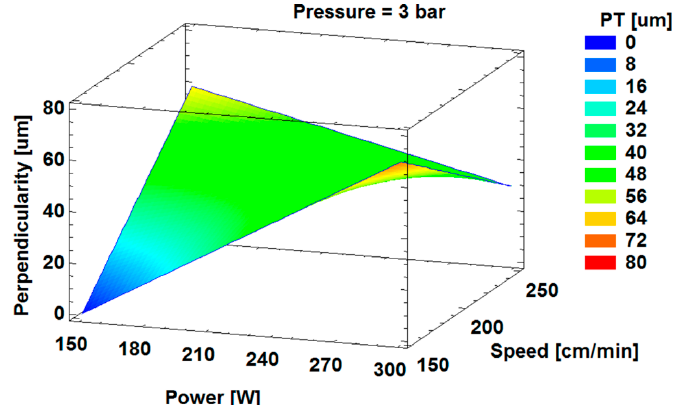
Figure 5. ( a ) Main effects and ( b ) interaction plots of perpendicularity tolerance. A: laser power; B: cutting speed; C: oxygen pressure. Polynomial trendlines have been used to fit perpendicularity tolerance data.